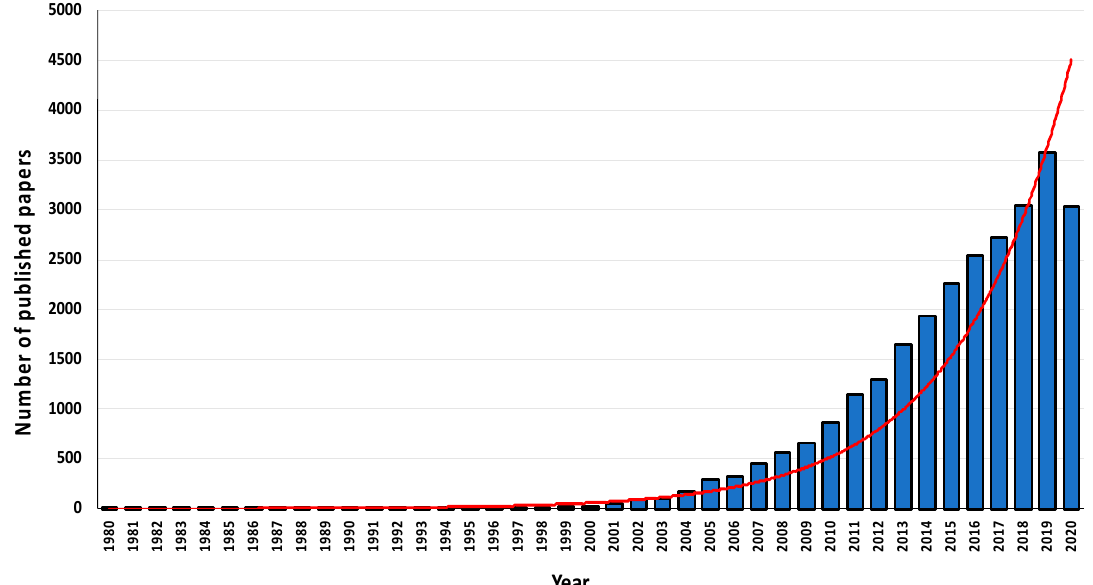
Figure 1. Timeline of published papers (number per year) from the PubMed website using the key “nonalcoholic fatty liver disease” (updated on 29 September 2020). The red line indicates the exponential growth of nonalcoholic fatty liver disease (NAFLD)-related publications over the last 40 years. The blue columns indicate the number of published papers for each year (reported on the x- axis).